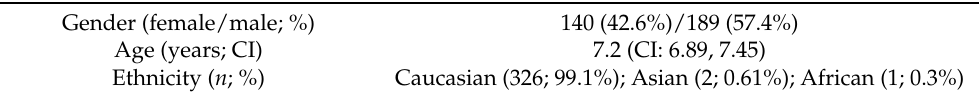
Table 1. Patients’ demographics ( n =